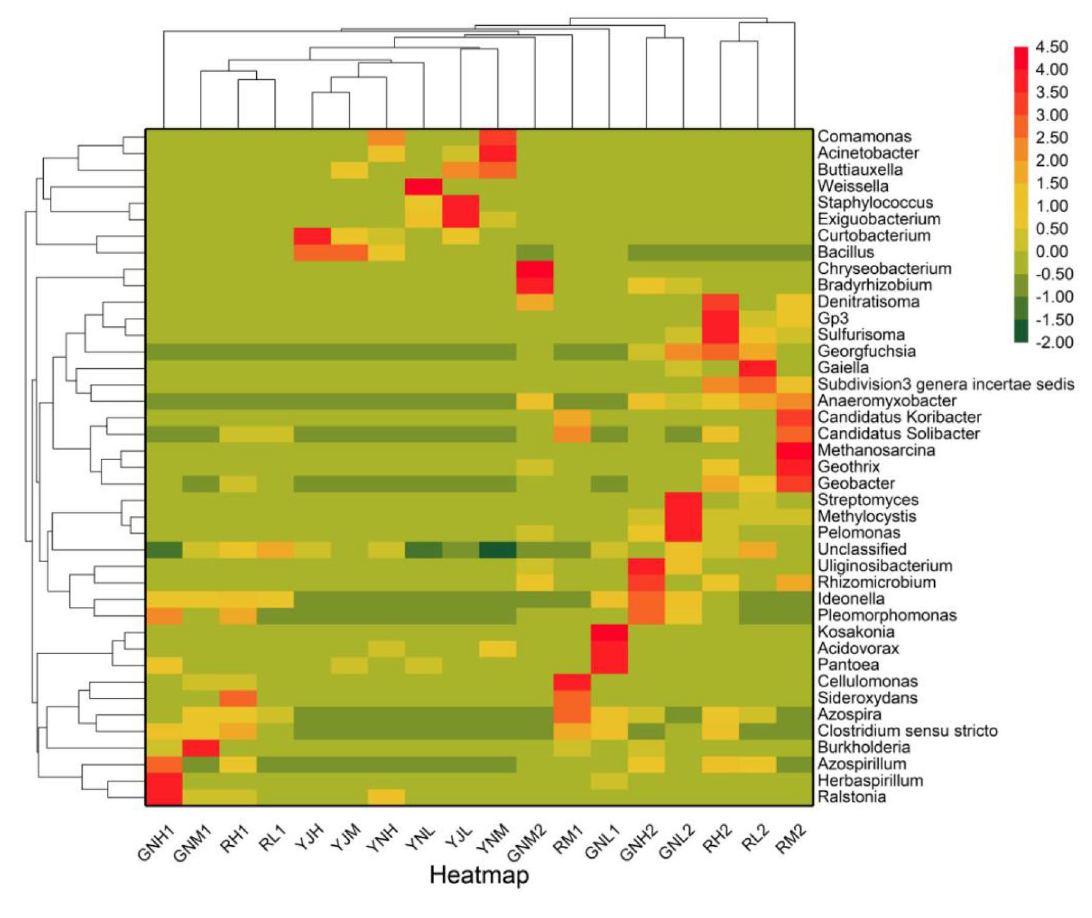
Figure 8. Heatmap of genus